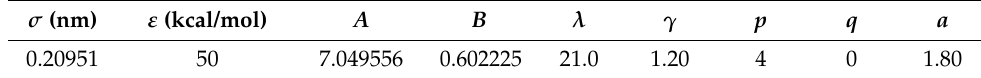
Table 1. SW potential